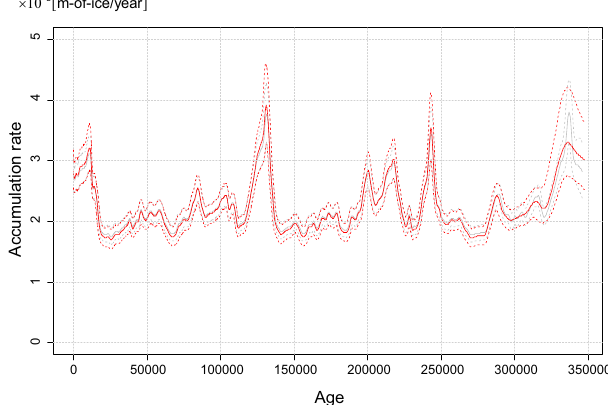
Figure 11. Estimated accumulation rate as a function of age: with- out using the last five tie points (red) and with all the tie points (grey). The solid lines indicate the median of the posterior distribu- tion. The 10th and 90th percentiles of the posterior are indicated by dotted